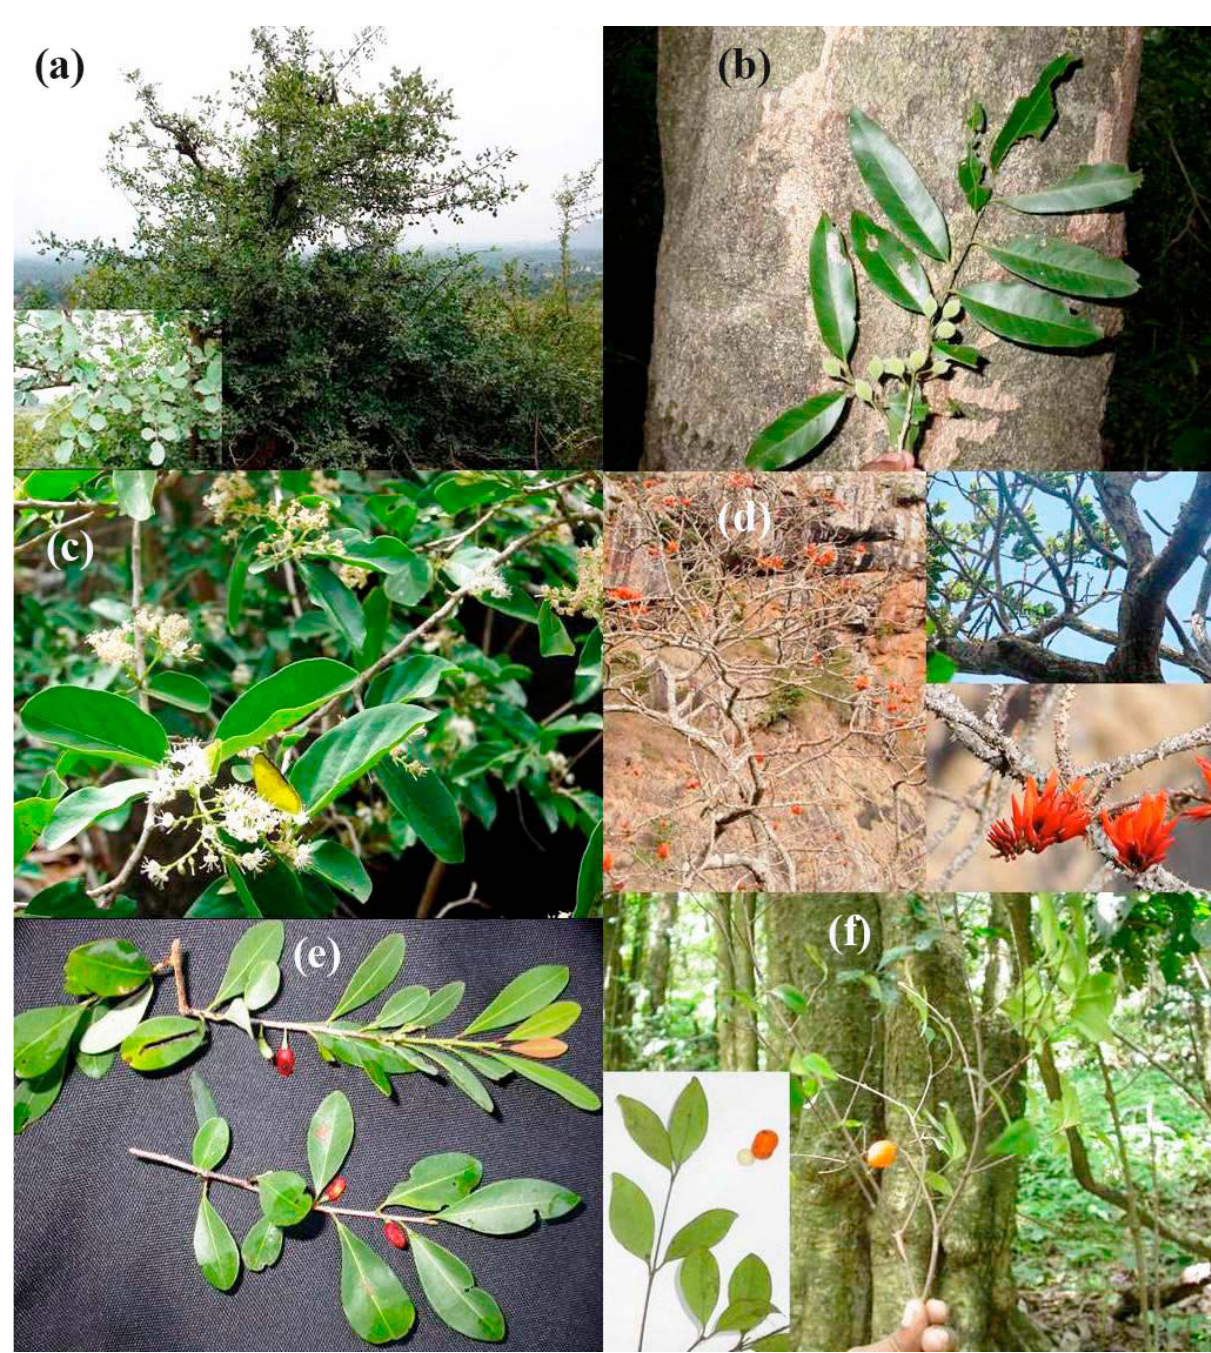
Figure 9. a) Dolichandrone arcuata (Bignoniaceae); b) Drypetes roxburghii (Euphorbiaceae); c) Ehretia pubescens (Cordiaceae); d) Erythrina stricta (Papilionaceae); e) Erythroxylum monogynum (Erythroxylaceae); f) Eugenia thwaitesii (Myrtaceae). Photo by L. Arul